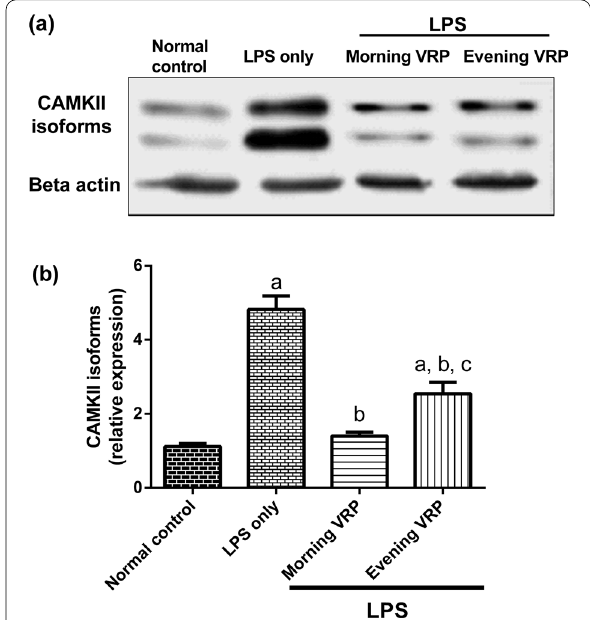
Fig. 8 Effect of VRP on CAMKII isoforms. a Band intensity of CAMKII α, β, γ, and δ isoforms for one representative sample for each studied group normalized against β-actin. b Column chart for relative expression of CAMKII isoforms, data are expressed as the mean and were analyzed using one-way ANOVA followed by Tukey post hoc test. Values were considered significantly different at P < 0.05. a: significant versus normal control, b: significant versus LPS only, and c: significant versus morning VRP. LPS: lipopolysaccharides, VRP: verapamil, CAMKII: Ca 2 + / calmodulin dependent kinase II